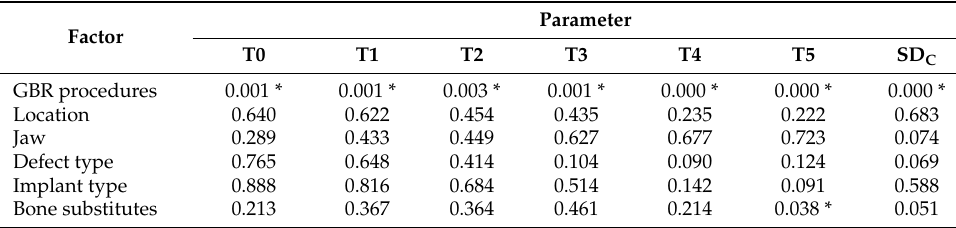
Table 2. Results of multi-factor ANOVA ( p value).